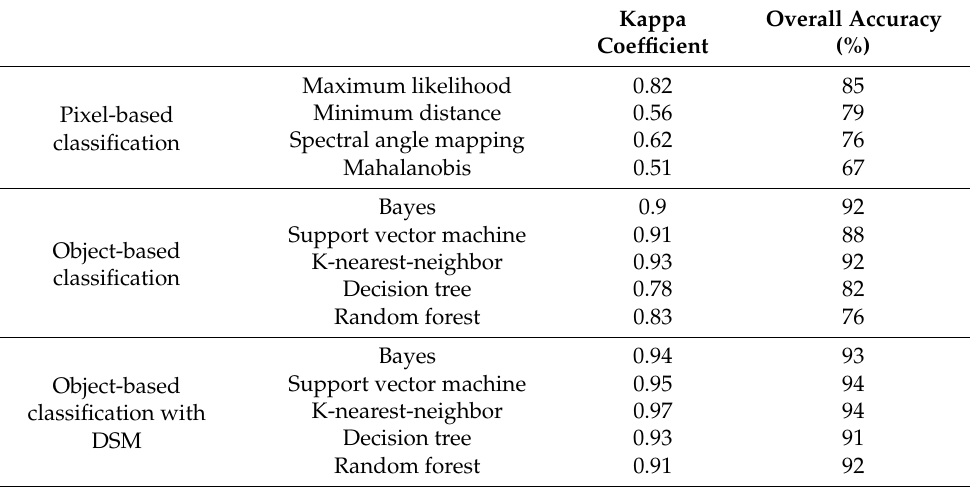
Table 2. Accuracy of classification of unmanned aerial vehicle (UAV) images using pixel-based methods, object-based methods and object-based methods with the digital spatial model (DSM).